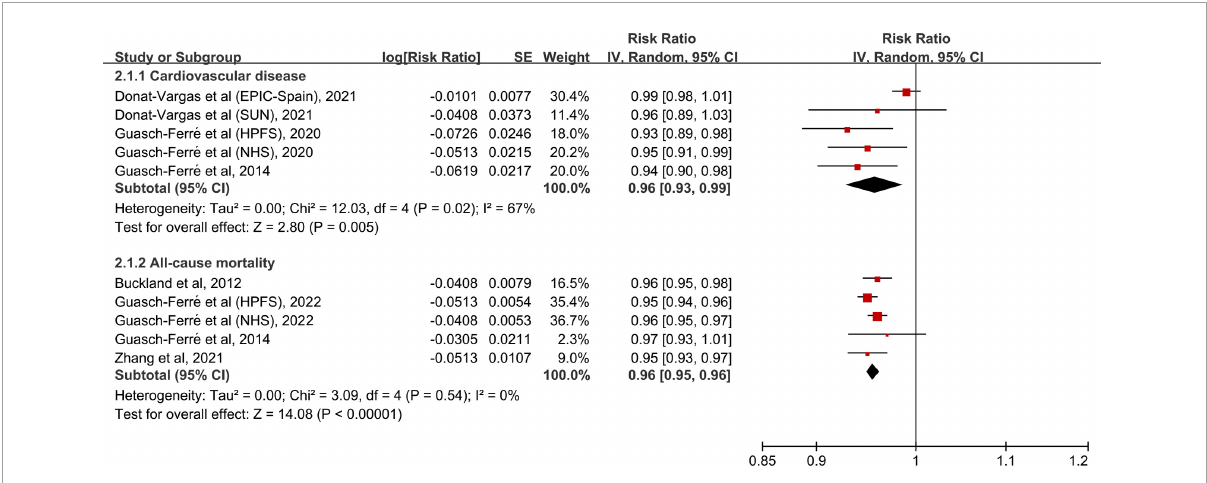
FIGURE3 Meta-analytic results for each 5-g/days increase in olive oil consumption. CI, confidence interval; SE, standard error.